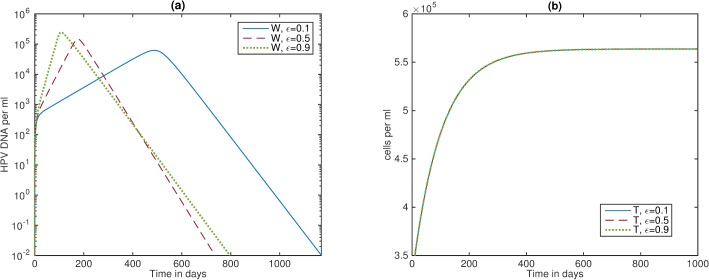
Effect of oncogene expression rates and cART on HIV/HPV co-infections.(a) HPV W; (b) CD4+ T cells T as given by model (5) under cART. Here, ε = 0.1 (blue solid line); ε = 0.5 (red dashed line); ε = 0.9 (green dotted line), εRT = 0.95, εPI = 0.5, and all other parameters are listed in Table 1. Initial conditions are T0 = 3.3x105 cells per ml, I0 = 2.4x105 cells per ml, V0 = 4.8x104 virions per ml, Y10 = 1 cells, E0 = 0.01 cells, Y20 = W0 = 0 and t = 0 is the start of cART.